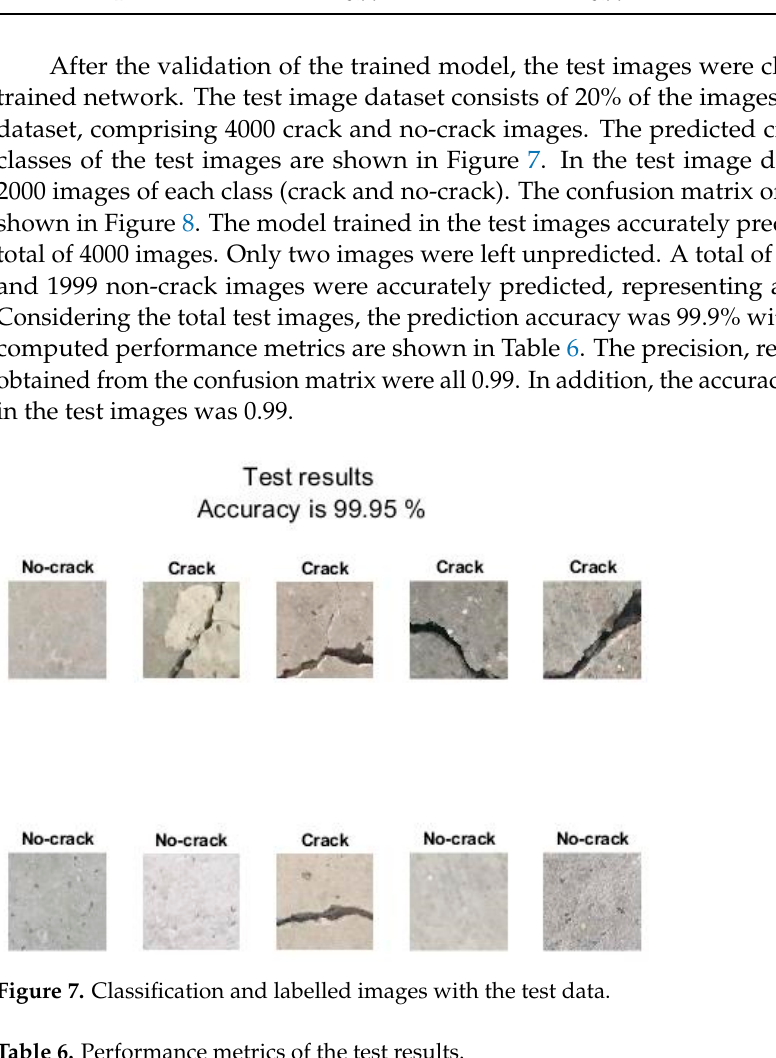
Figure 6. Confusion matrix of validation images.